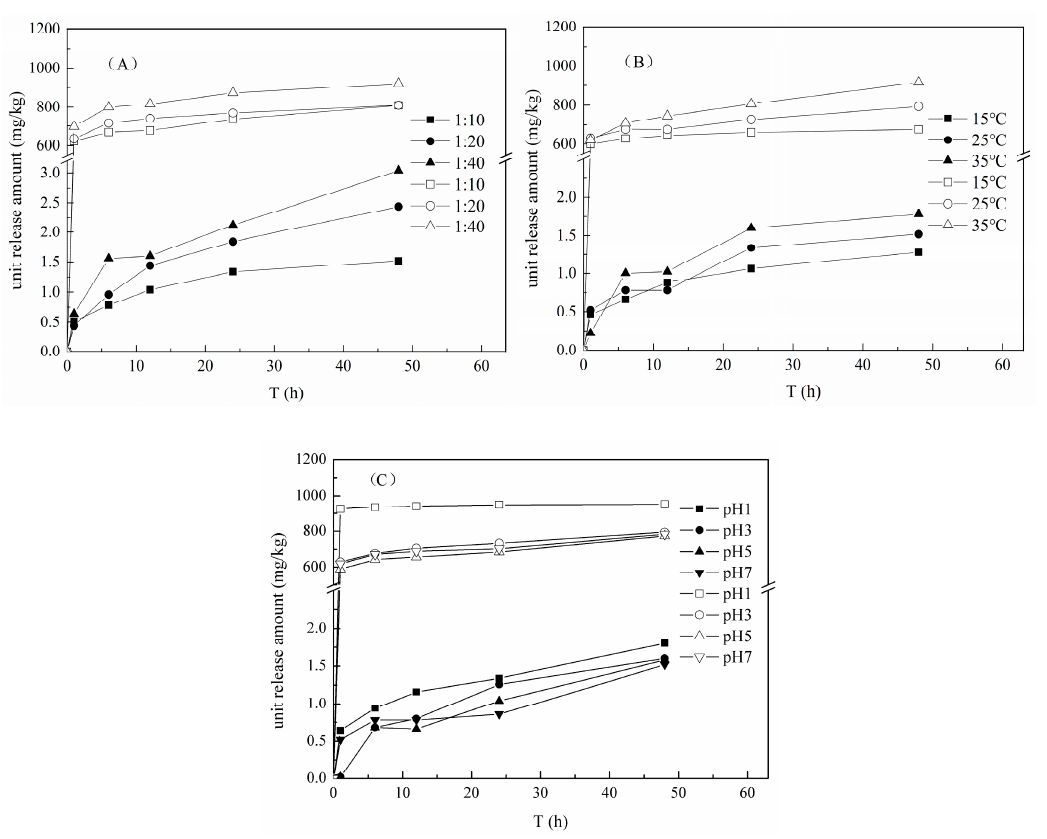
Figure 1. The release amounts of Cr(III) and NH 4 + -N under the di ff erent conditions (( A ): solid-liquid ratio (SLR); ( B ): temperature; ( C ): pH; Solid legend means Cr(III), and hollow legend means NH 4 + -N).